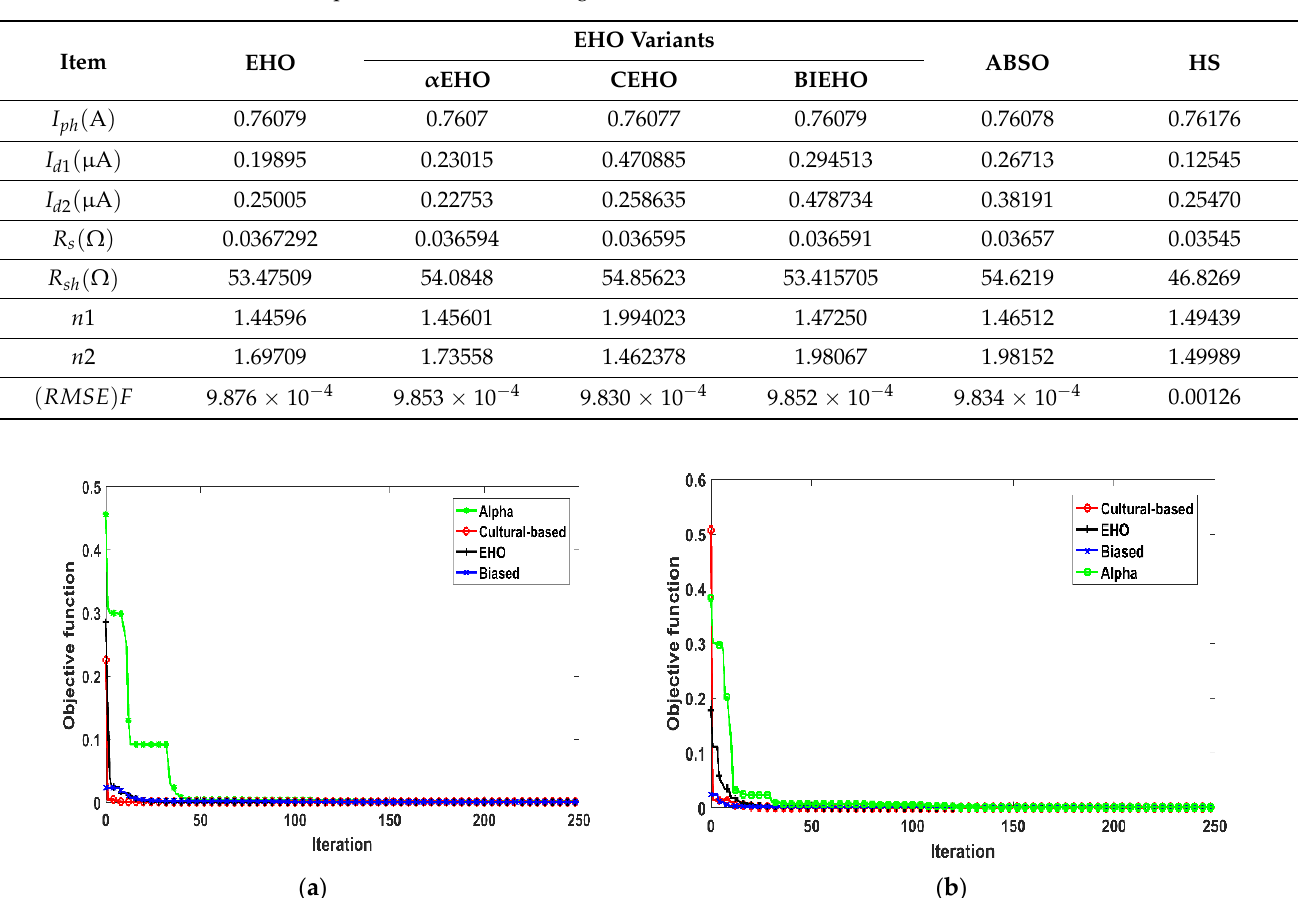
Table 4. Comparison between EHO algorithms, ABS, and HS for double-diode solar cells.